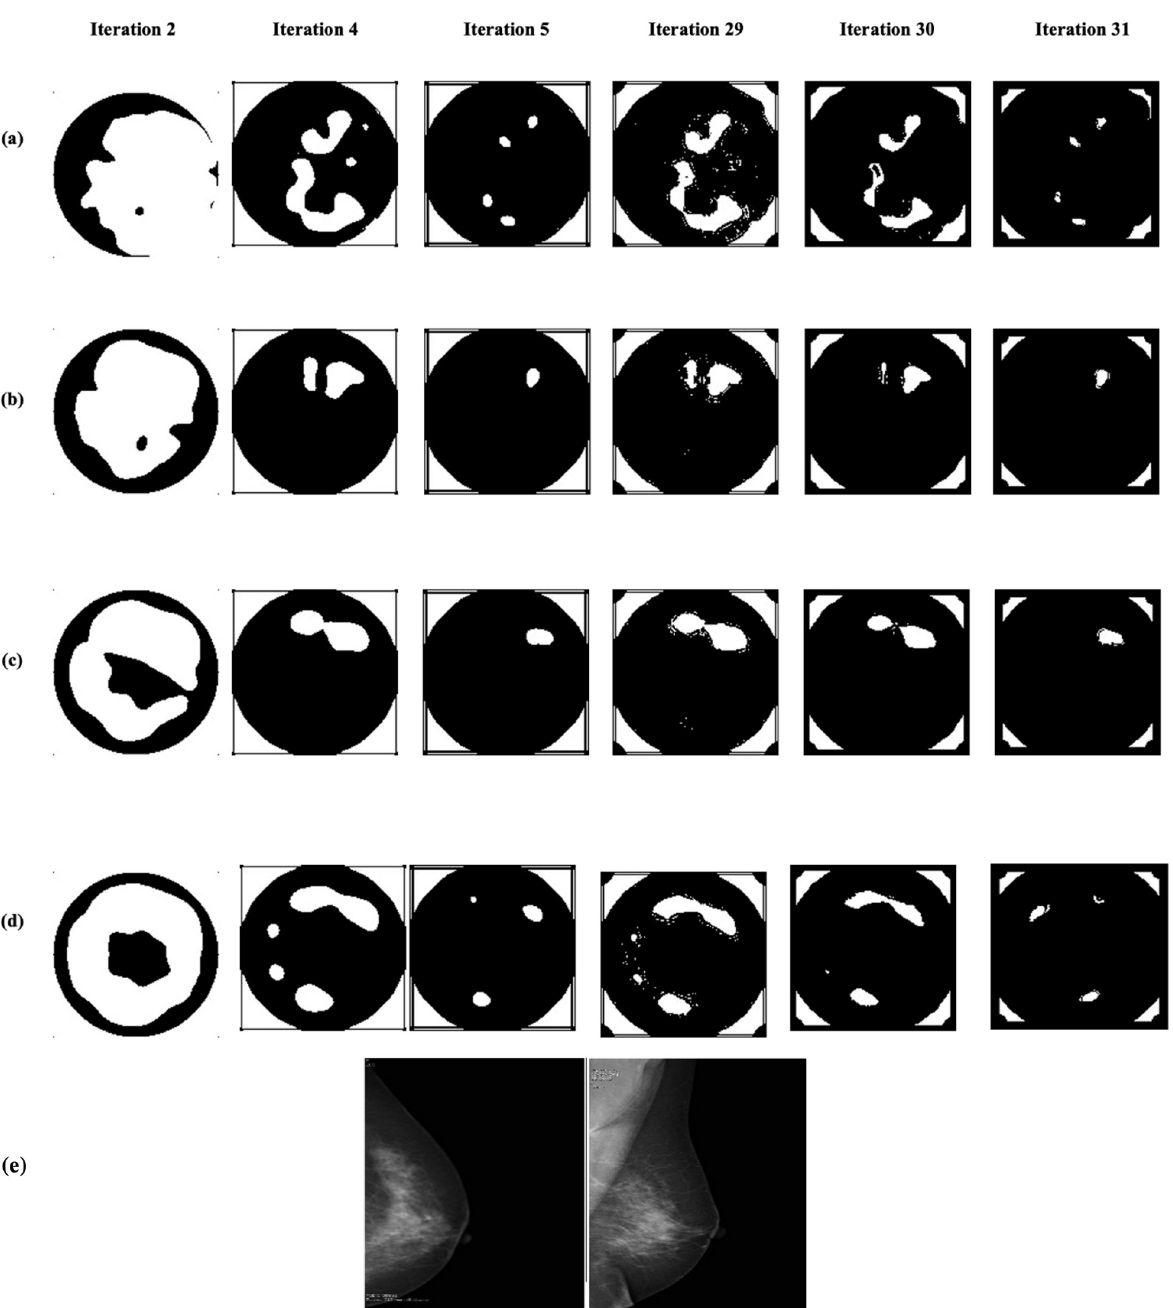
Fig 5. Six PCNN iterations for one MF breast images for different conductivity (a) input image formed using σ 1 , (b) input image formed using σ 2 , (c) input image formed using σ 3 , and (d) input image formed using σ 4 . The radiologist study review “MF” for this heterogeneously dense breast has been obtained with the support of mammography images given in the bottom row, giving as output the presence of a cluster of microcalcifications, plus